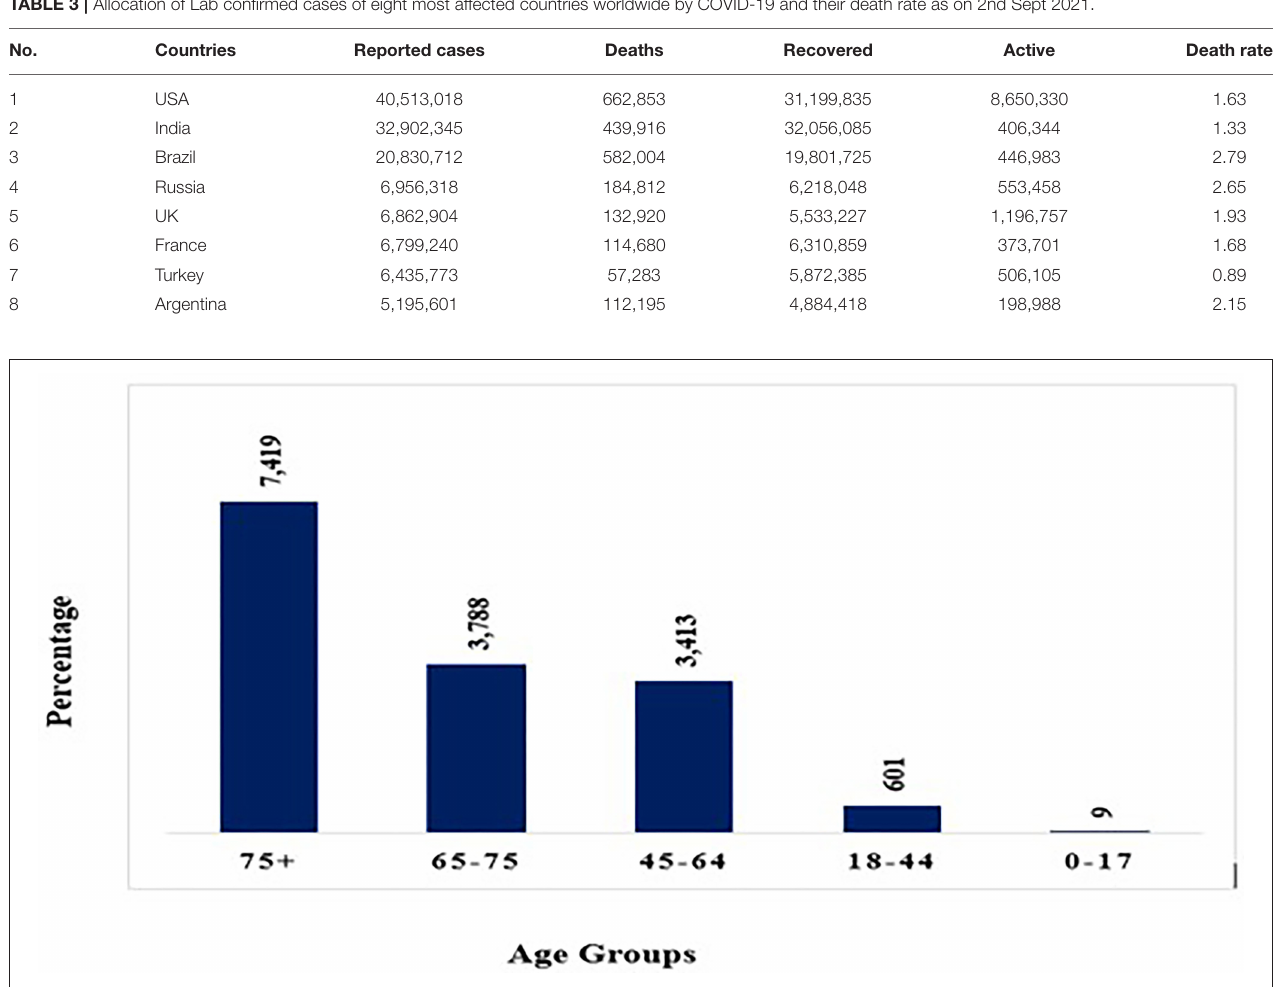
FIGURE 4 | COVID-19 death rate by different age